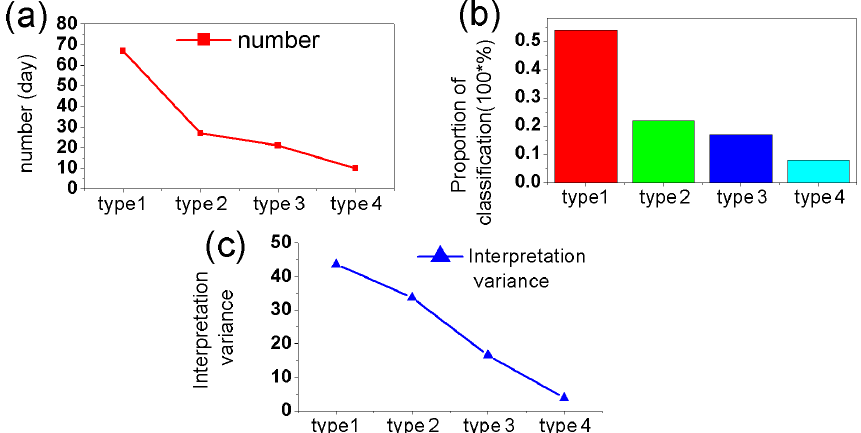
Figure 2. The four pollution weather types as a function of their (a) number of samples, (b) proportion with respect to the total number of samples, and (c) interpretation